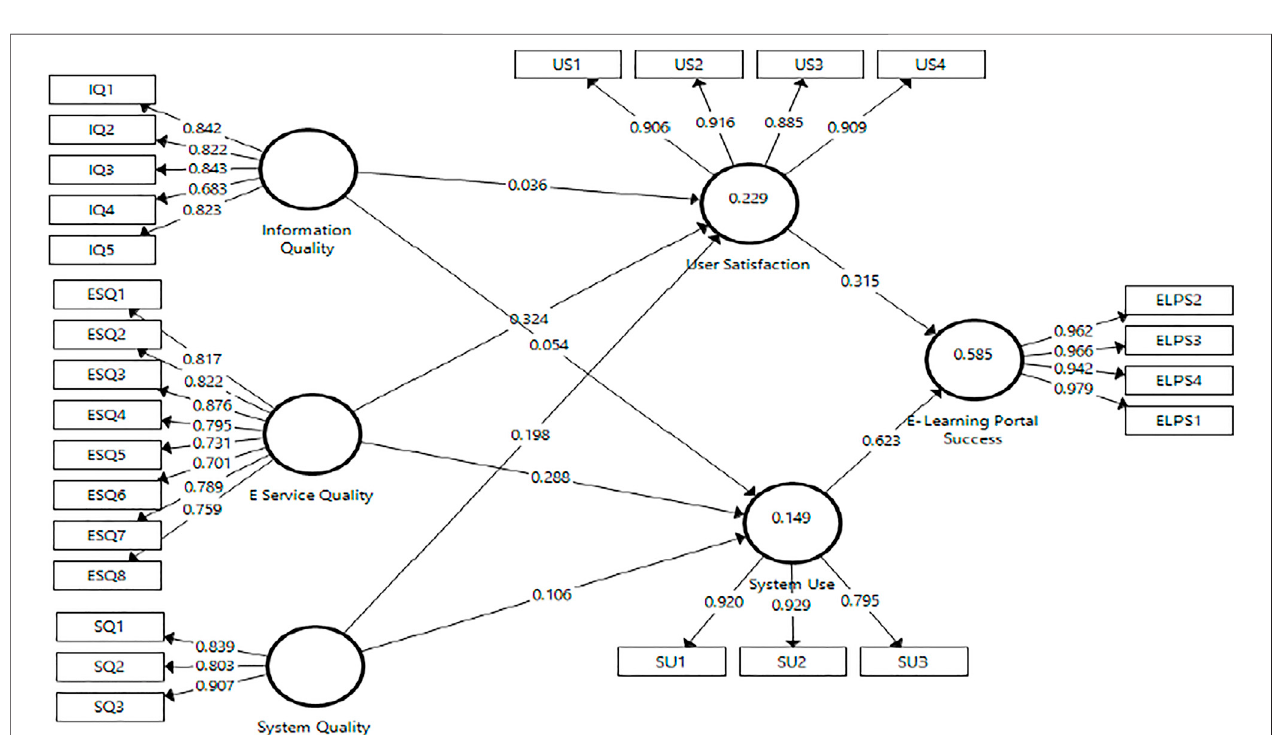
FIGURE 4 | Male measurement